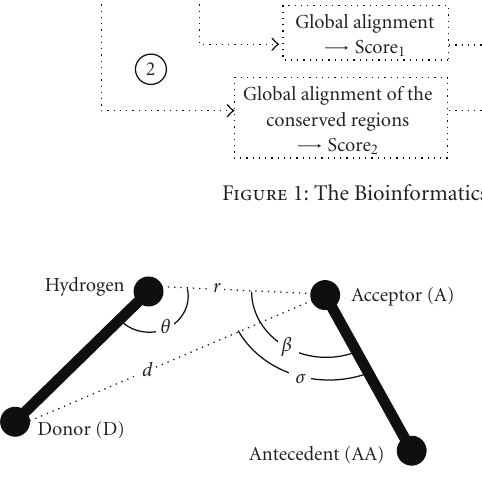
Figure 1. The algorithm predicts the protein interactors